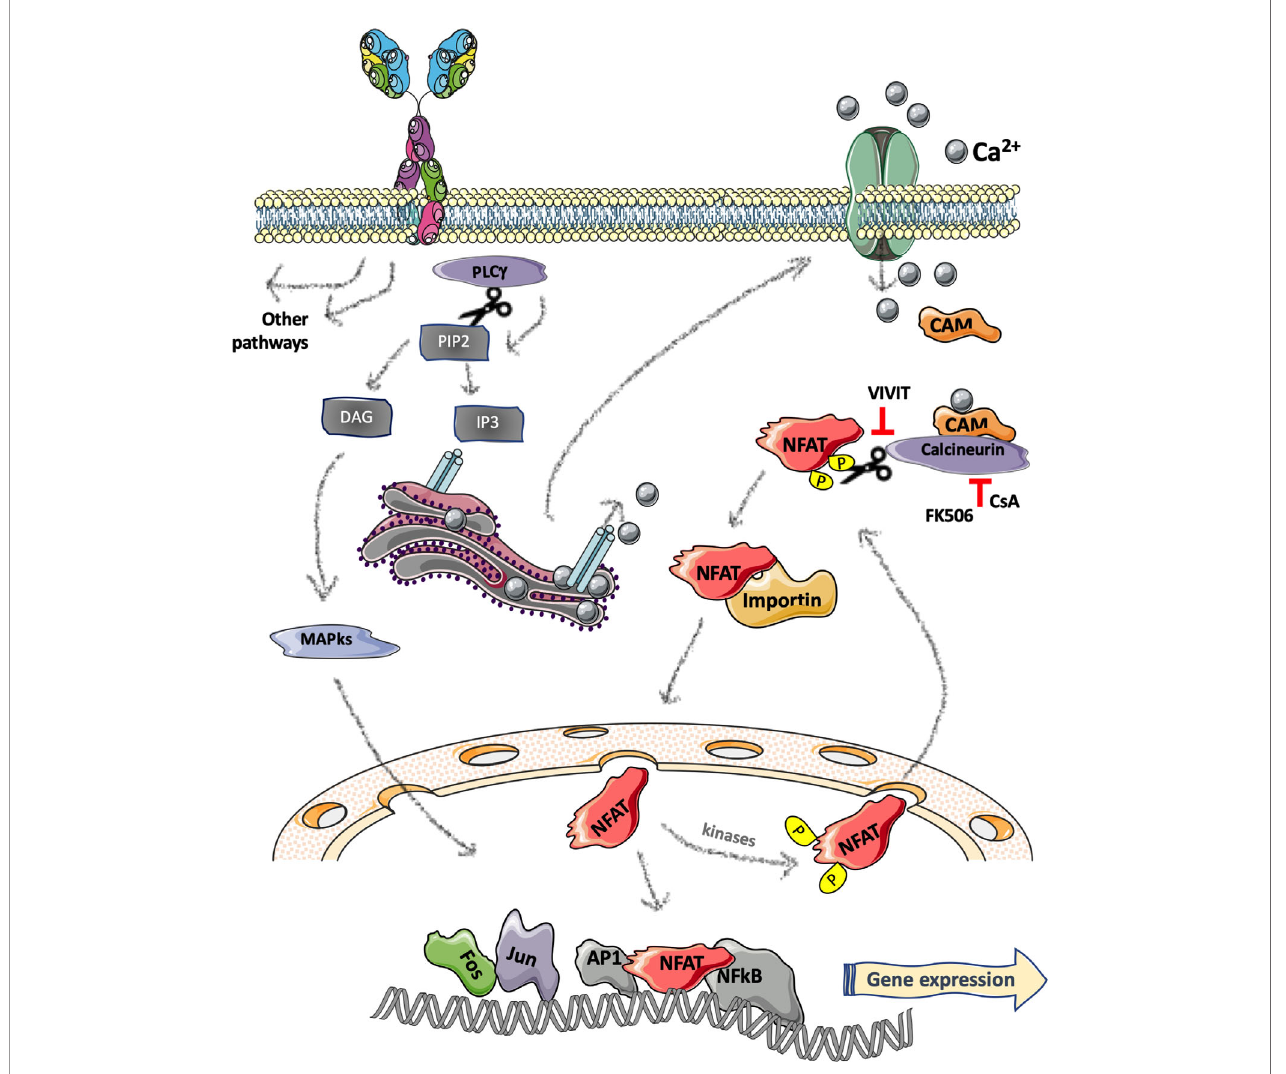
FIGURE 2 | Schematic representation of B-cell receptor induced NFAT pathway. Stimulation of the B-cell receptor (BCR) activates a cascade resulting in phospholipase C (PLC g ) activation and hydrolyzation of phosphatidylinositol-3,4-bisphosphate (PIP 2 ) generating the release of two second messengers: diacylglycerol (DAG) and inositol-1,4,5-trisphosphate (IP3). IP3 binds to the IP3 receptor located on the endoplasmic reticulum leading to release of Ca 2+ from the ER and an extracellular in fl ux of Ca 2+ in the cytosol that causes the binding of calmodulin (CaM) to the calcineurin phosphatase and the consequent dephosphorylation and activation of NFAT. The nuclear translocation of NFAT is mediated by nuclear importing factors (e.g., importin). In the nucleus, NFAT binds to the DNA either alone or with other factors regulating gene expression. Figure 2 was created using Servier Medical Art